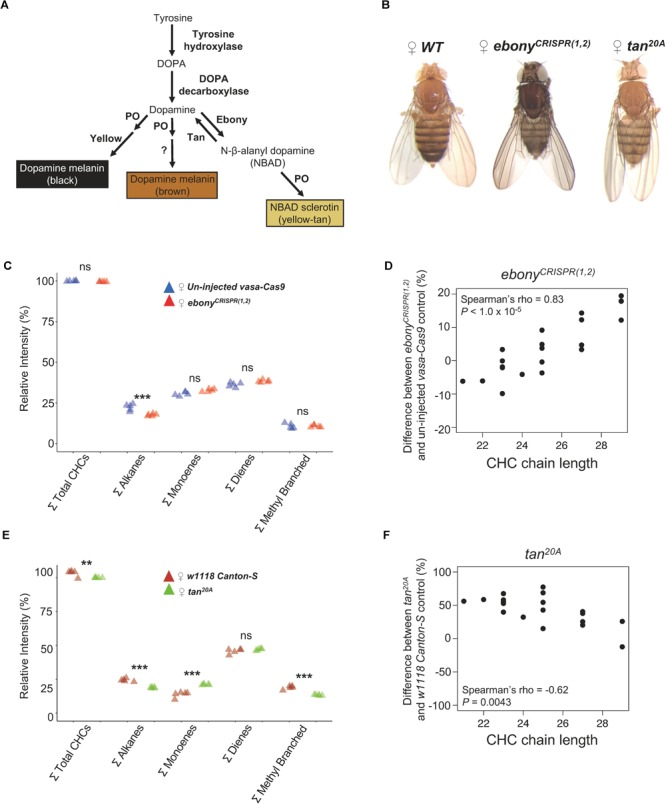
ebony and tan affect pigmentation and CHC composition in female Drosophila melanogaster. (A) Insect sclerotization and pigmentation synthesis pathway. Ebony converts dopamine into N-β-alanyl dopamine (NBAD) which is oxidized into yellow-colored NBAD sclerotin. Tan catalyzes the reverse reaction, converting NBAD back into dopamine that can be oxidized into black and brown melanins. (B) Photographs highlighting the effects of ebonyCRISPR(1,2) (darker) and tan20A (lighter) on body pigmentation compared to the un-injected vasa-Cas9 control line (WT). (C) Summary of ebonyCRISPR(1,2) effects on total summed CHC classes relative to un-injected vasa-Cas9 control females. (D) Difference in log-contrast of relative CHC intensity between ebonyCRISPR(1,2) and un-injected vasa-Cas9 control flies. (E) Summary of tan20A effects on total summed CHC classes relative to w1118 Canton-S control females. For (D,E), each triangle represents a single replicate of CHCs extracted from five pooled individuals (N = 5 replicates per genotype). (F) Difference in log-contrast of relative CHC intensity between tan20A and w1118 Canton-S control flies. Results of Tukey HSD post hoc tests following one-way ANOVA are shown: ∗P < 0.05, ∗∗P < 0.01, ∗∗∗P < 0.001.